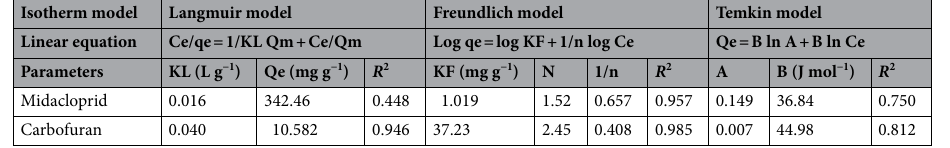
Table 3. Adsorption isotherm models for the adsorption of carbofuran and imidacloprid on Silica monolith— GO composite.